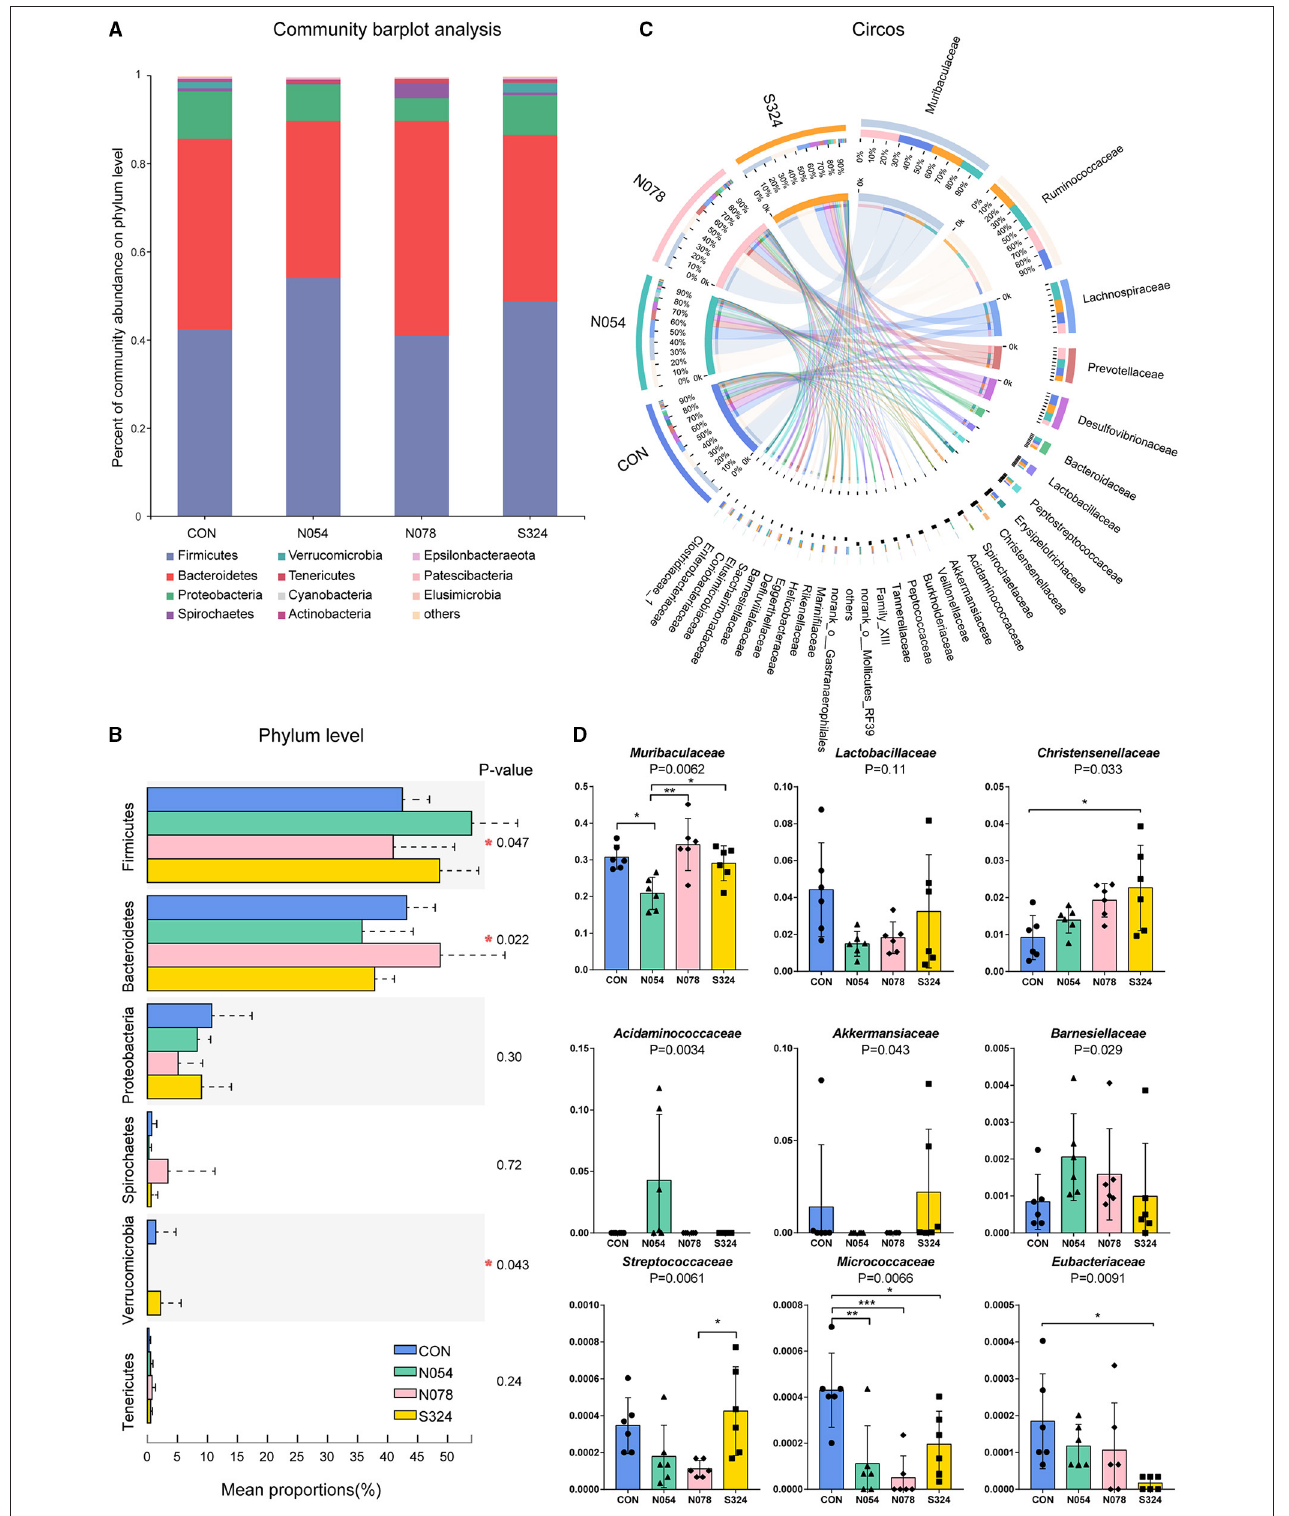
FIGURE 2 | Main bacterial communities of different taxonomies. (A) Community bar plot of the domain phyla. (B) Relative abundant of the domain phyla of four groups. (C) Circos plot showing the relationship between microbial families and samples. (D) Relative abundance of core bacterial families. Kruskal–Wallis rank sum test with Tukey–Kramer post-hoc analysis was performed ( n = 6). Mean ± standard error. * p < 0.05, ** p ≤ 0.01, *** p ≤ 0.001.